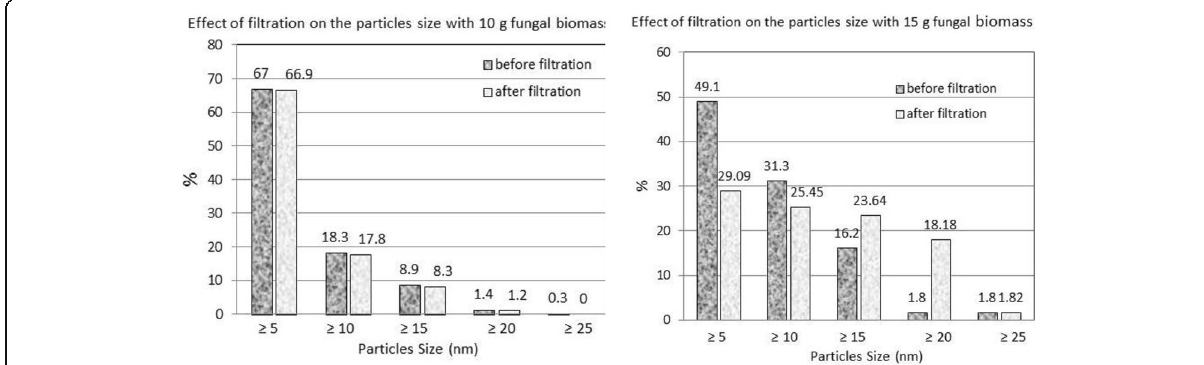
Fig. 7 Distribution of AgNP size from TEM